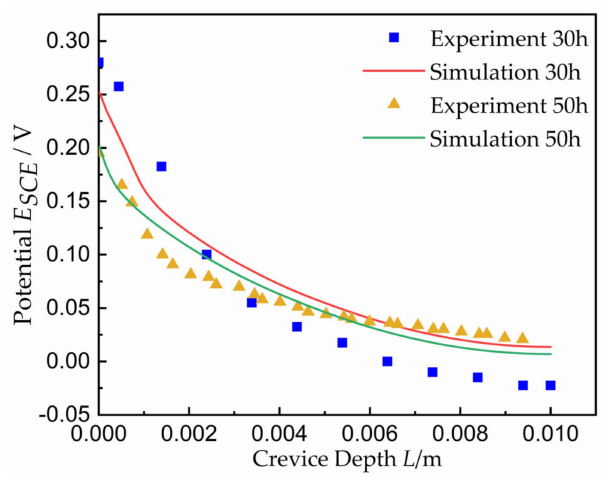
Figure 7. Comparison of potential with experimental results from Abdulsalam [35].